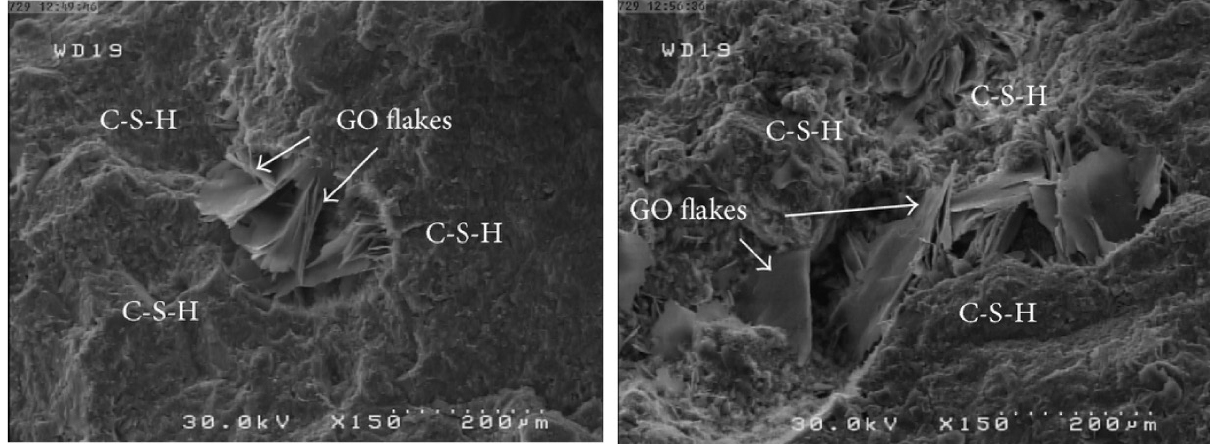
Figure 6: SEM images of cement containing GO, showing the nucleation of C-S-H by GO [106]